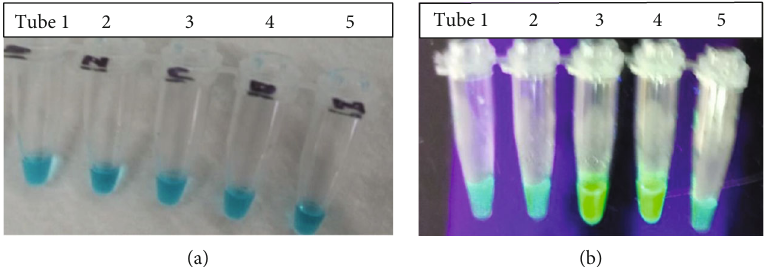
Figure 4: (a) LAMP reaction mix before ampli fi cation. (b) LAMP mix reaction after ampli fi cation. (a) All reaction mix in tubes 1 – 5 was blue in color before incubation. On incubating the reaction mix at 63 ° C for 60 minutes, the results were as shown in (b) on the addition of 1:10 SYBR Green dye and viewed under a UV Light or under sunlight. Tubes 1 and 2 remained blue in color indicating the absence of Wuchereria bancrofti DNA (negative specimen), tube 3 turned green in color indicating positive W. bancrofti DNA ampli fi cation (positive specimen), tube 4 contained W. bancrofti DNA-positive control which turned green in color, and tube 5 was a negative control which remained blue in color.